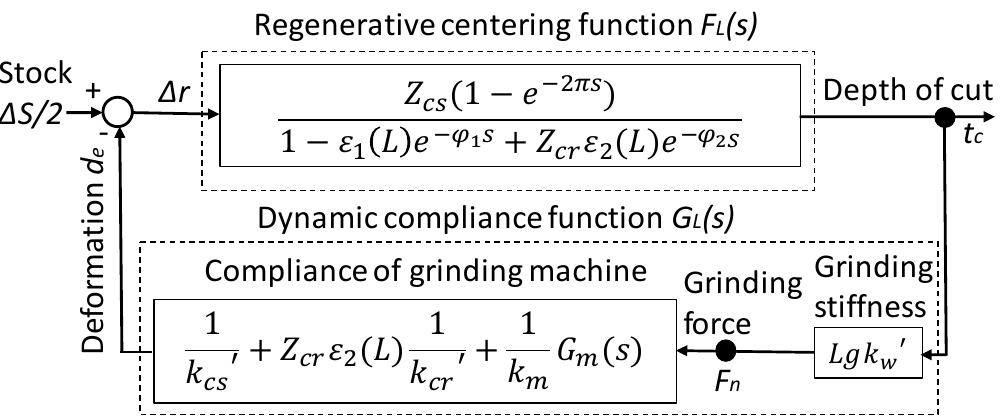
Figure 3. Dynamic rounding loop at grinding position in through ‐ feed centerless grinding system.